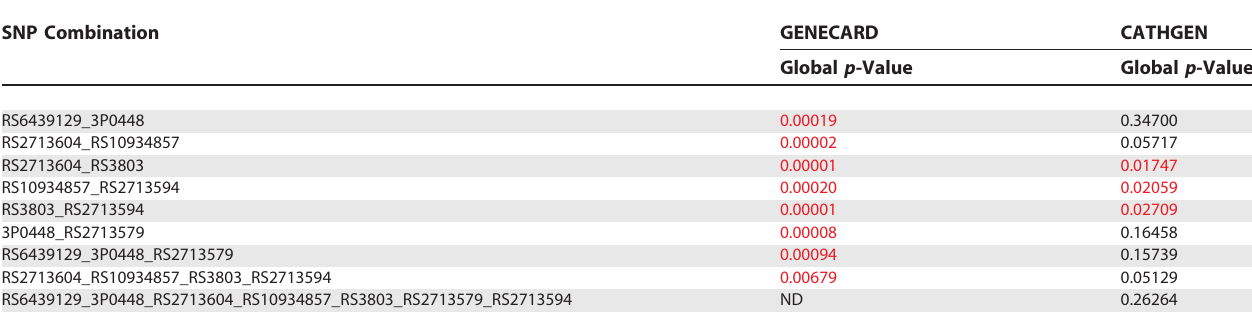
Table 5. Haplotype Analysis Identifies Significant Haplotypes Associated with Early-Onset CAD